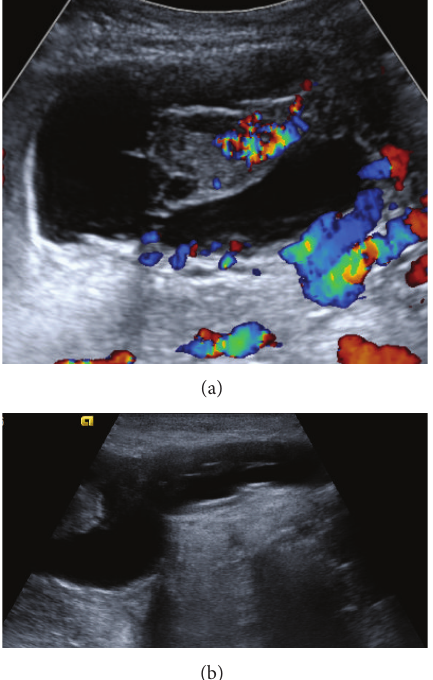
Figure 1: (a) Ultrasound demonstrating an avascular cystic collection in the right adnexal region, containing ovarian tissue that is connected to the peritoneum by a pedicle. (b) Ultrasound demonstrating extension of cystic mass into the right inguinal canal.